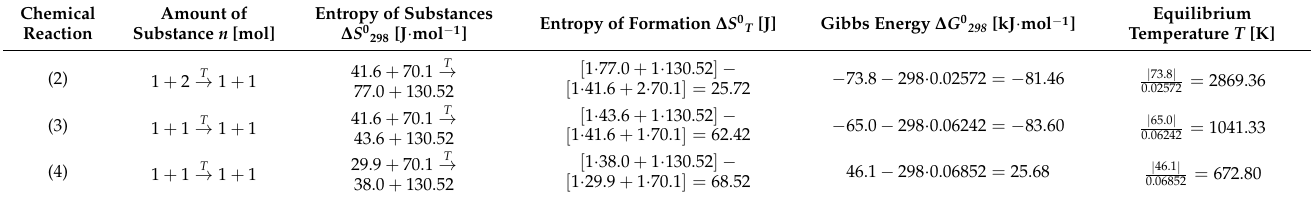
Table 9. Calculated entropy of some Zn- and Ni-containing substances and equilibrium temperatures. Chemical Amount of Reaction Substance n